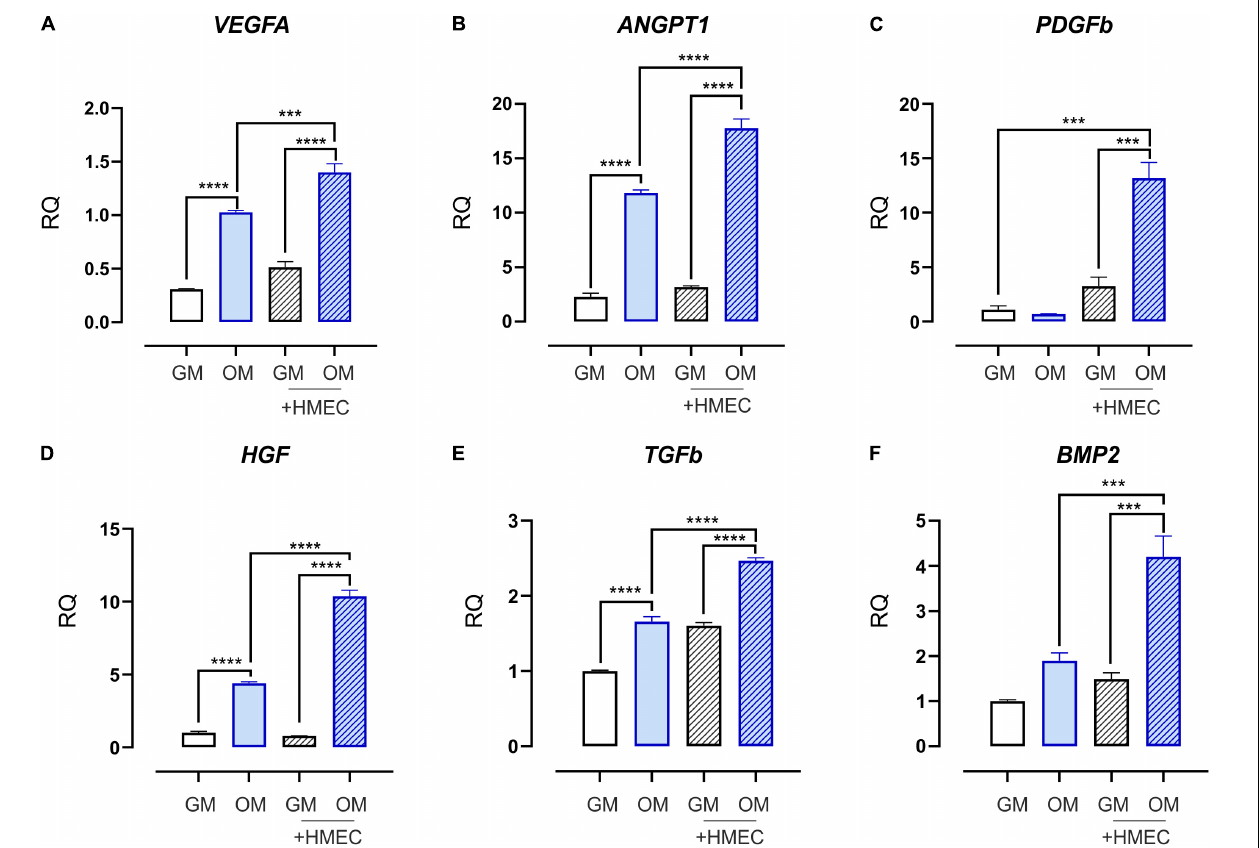
FIGURE 2 | Expression profile of growth and angiogenic factors in SHED cocultured with HMEC. qRT-PCR analysis performed on SHED under basal conditions (without EC) or after 4 h of coculture with HMEC. Undifferentiated (white bars) and osteodifferentiating (blue bars) SHED is shown. Data represent mean ± SEM; n = 3. *** p < 0.001; **** p < 0.0001. Statistical analysis: ordinary one-way ANOVA with Tukey’s multiple comparisons test. (A) VEGFA , vascular endothelial growth factor A; (B) ANGPT1 , angiopoietin 1; (C) PDGFb , platelet-derived growth factor b; (D) HGFb , hepatocyte growth factor b; (E) TGFb , transforming growth factor b; (F) BMP2 , bone morphogenetic protein